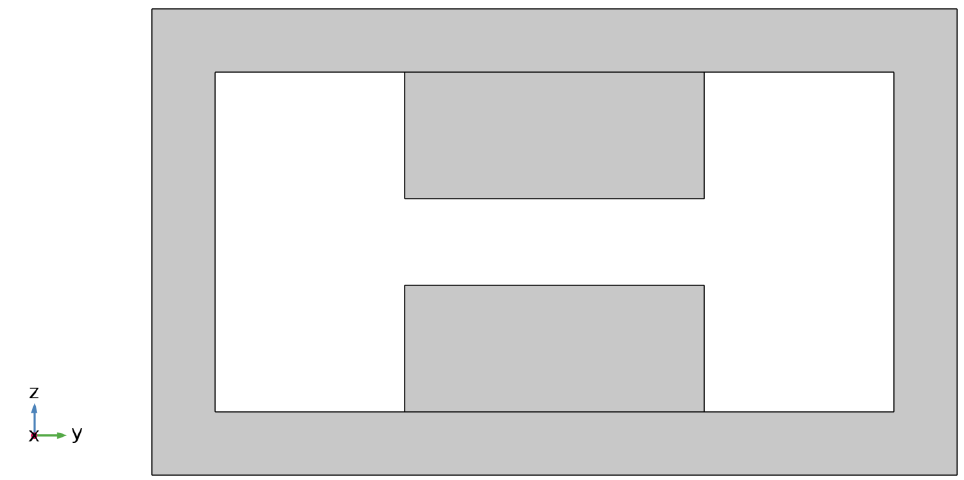
Figure 1. The cross-section of a double-ridged waveguide.